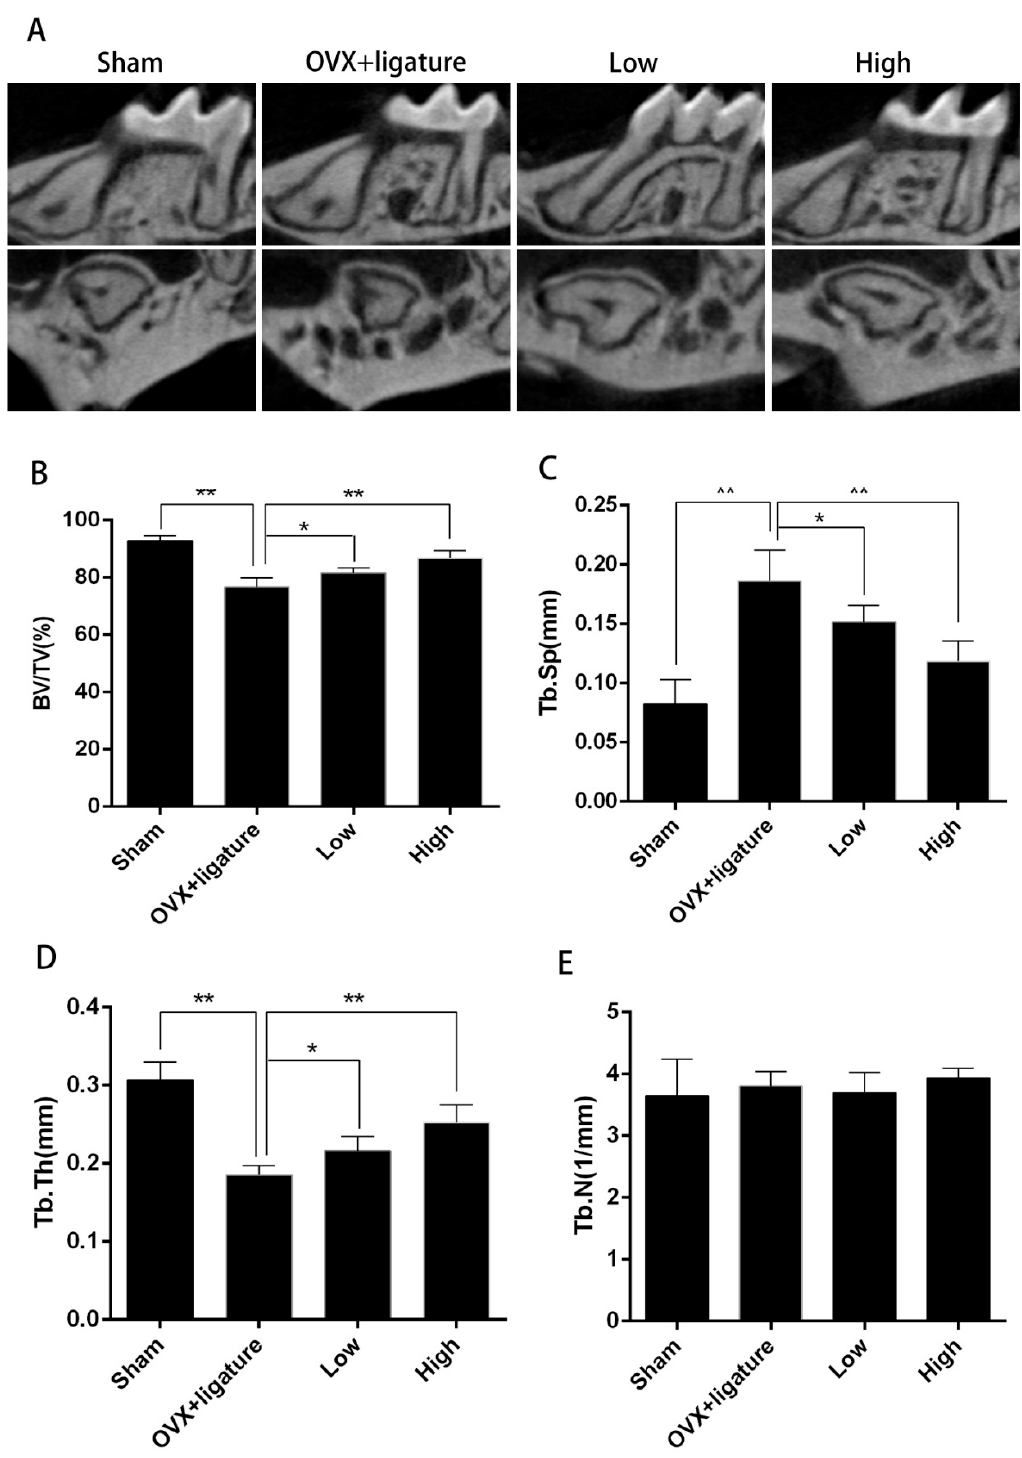
Figure 1. Micro computed tomography (CT) analysis of bone volume showing effect of myricetin on maxilla parameters. ( A ) Longitudinal and transverse-sectional micro-CT images of first molar (M1) in maxilla; ( B – E ) Analysis of micro-CT volumetric parameters: bone volume/tissue volume (BV/TV), trabecular separation (Tb.Sp), trabecular thickness (Tb.Th), trabecular number (Th.N), and ovariectomized (OVX); * p < 0.05, ** p < 0.017; n = 6.